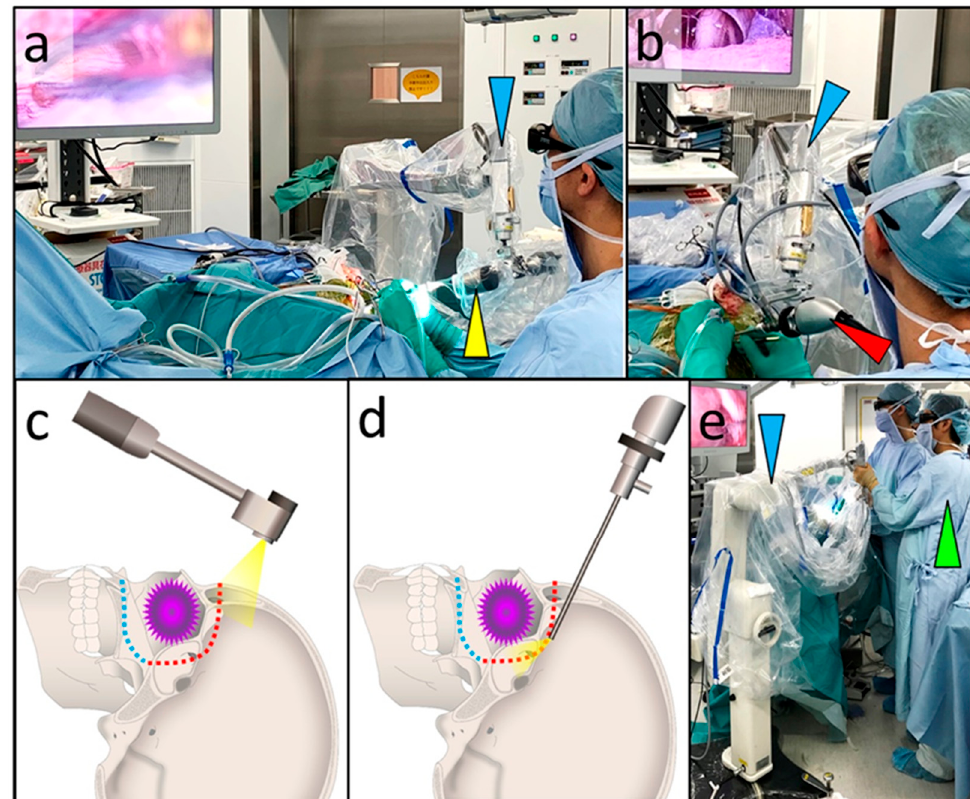
Figure 2. Photographs and schematic diagrams of combined exoscope and endoscope technique in the transcranial approach for craniofacial resection. ( a ) The majority of the transcranial procedures were performed using the VITOM-3D exoscope (yellow arrowhead), held by the Mitaka UniARM (blue arrowhead). The VITOM-3D does not have an eyepiece, and the surgeon performs the operation while viewing images (with 3D glasses) of the surgical field on a monitor. ( b ) Transections in the blind spots of the exoscope are visualized with an endoscope (red arrowhead), which is also held by the Mitaka UniARM (blue arrowhead). ( c ) Transcranial procedures are performed using VITOM-3D-delivered stereoscopic vision (with the exception of blind spots) in the same manner as traditional microsurgery. Purple: tumor. Red broken line: transcranial skull base transection. Blue broken line: transfacial skull base transection line. ( d ) The endoscope enables direct visualization behind the lesions, a location that is difficult to access with an exoscope or microscope. Purple: tumor. Red broken line: transcranial skull base transection. Blue broken line: transfacial skull base transection line. ( e ) The exoscope and endoscope held by the Mitaka UniARM (blue arrowhead) are controlled by scopists (green arrowhead); 3D, three-dimensional.